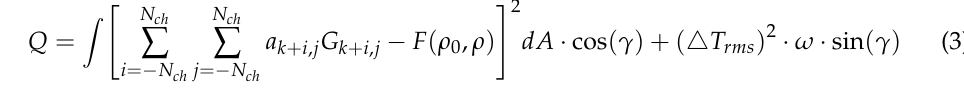
(cid:26) 1 for channel 1–2 where N ch = 3–16, i , and j usually refer to the direction along the scan line 2 for channel and across the scan line and a k + i , j represents the resampling coefficient. Therefore, the BGI resampled brightness temperature T BG is estimated as a linear combination of the a adjacent observed T a . In Equation (2), the two-dimensional window is transformed into a one-dimensional form. Mathematically, it is an ill-conditioned linear inversion problem, and regularization must be carefully considered in order to suppress the amplification of noise during inversion [26]. A dynamic balance is required between resolution and noise. The resampling coefficient a k + i , j can be obtained by minimizing the error function Q :